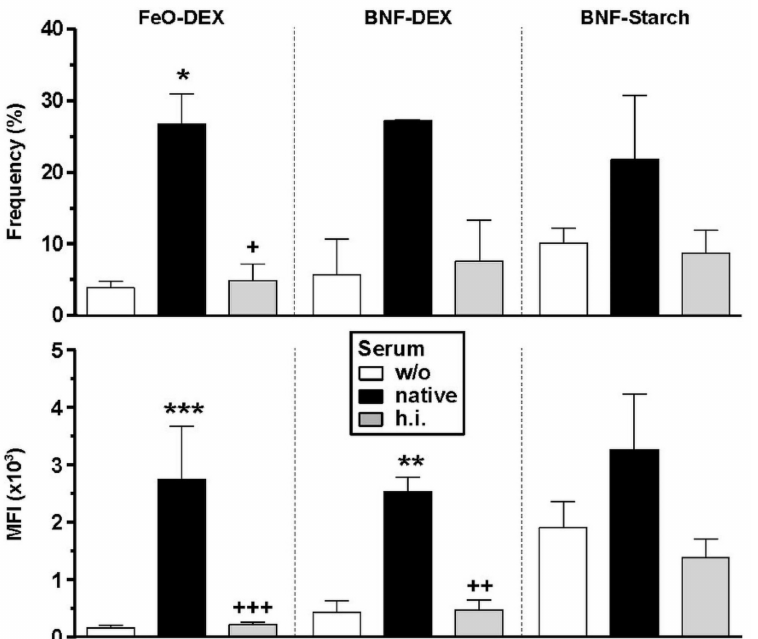
Figure 2. BMDC that express CR3 and CR4 engage carbohydrate-coated NC to a higher extent when pre-incubated with native serum. BMDC were incubated for 3 h with differentially pretreated (left untreated (w/o), pretreated with native or heat-inactivated (h.i.) serum) carbohydrate-coated types of NC. NC binding to CD11c + DC was assessed by flow cytometry and is given as MFI (mean ± SEM of 3 experiments). Details on the gating strategy are given in Figure S7. Statistical differences versus * w/o serum and + native serum are indicated (one-way ANOVA, Tukey’s test). * ,+ p < 0.05, ** ,++ p < 0.01, *** ,+++ p <